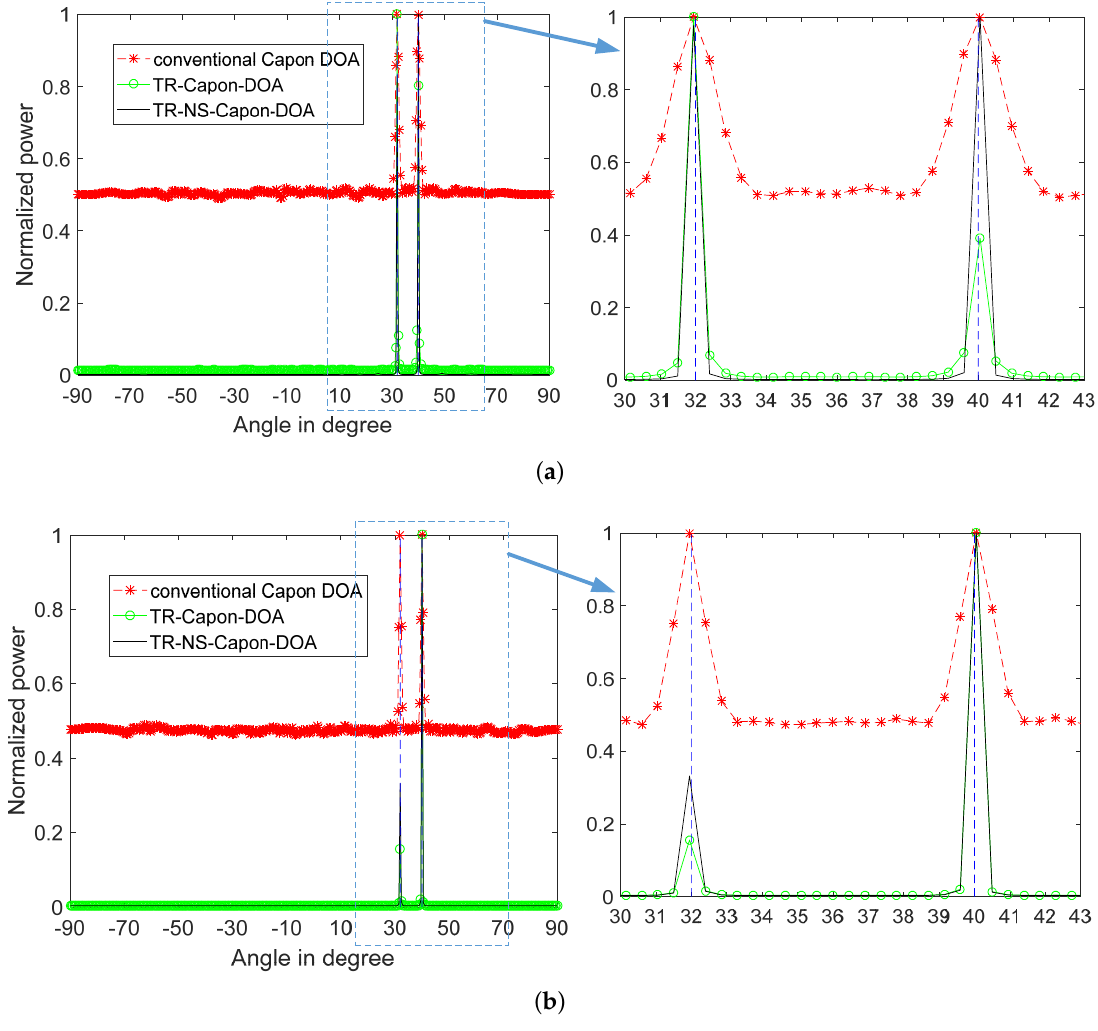
Figure 12. 2-path normalized power spectra versus angles for conventional Capon DOA, TR-Capon-DOA and TR-NS-Capon-DOA algorithms under the condition of LFM used as ES, SNR = − 15 dB and ( a ) conventional CA ( b ) Optimized